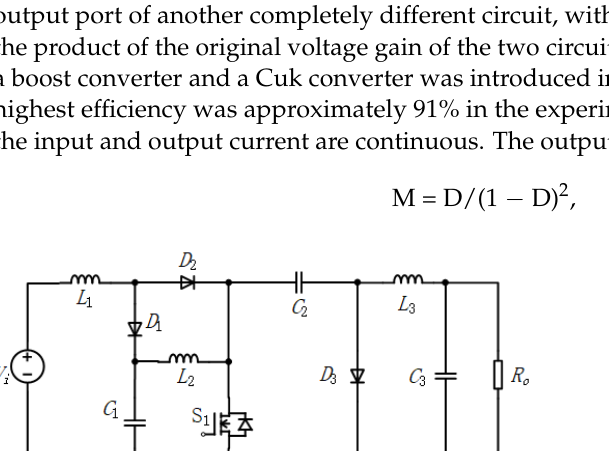
Figure 23. Basic quadratic buck-boost DC-DC converters. ( a ) [46]. ( b ) [47]. ( c ) [48].